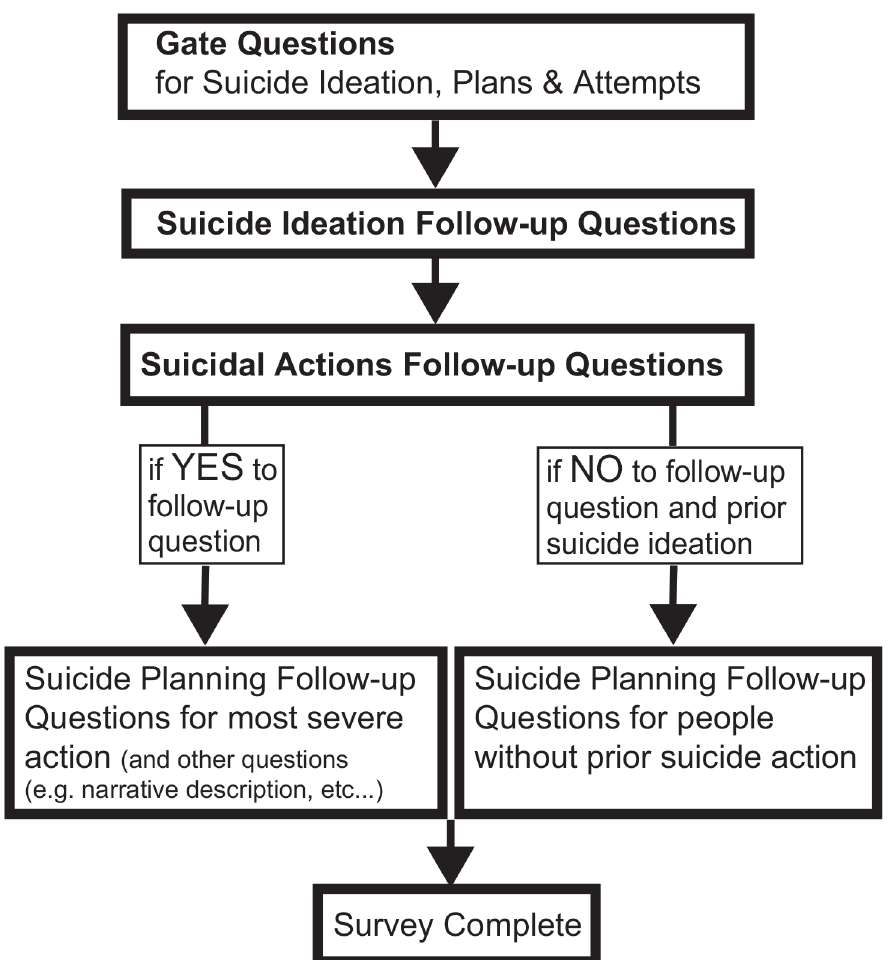
Fig 1. A flow chart of the online survey. Gate questions are single-item questions for three suicidal outcomes. Suicide ideation follow-up questions include eight different thoughts and suicide action follow-up questions include five different actions. Participants that denied any suicidal thoughts or behaviors in the first three sections skipped to the end of the survey. Participants that endorsed any suicidal thought or behavior completed several follow-up questions regarding planning behaviors and narrative descriptions of their